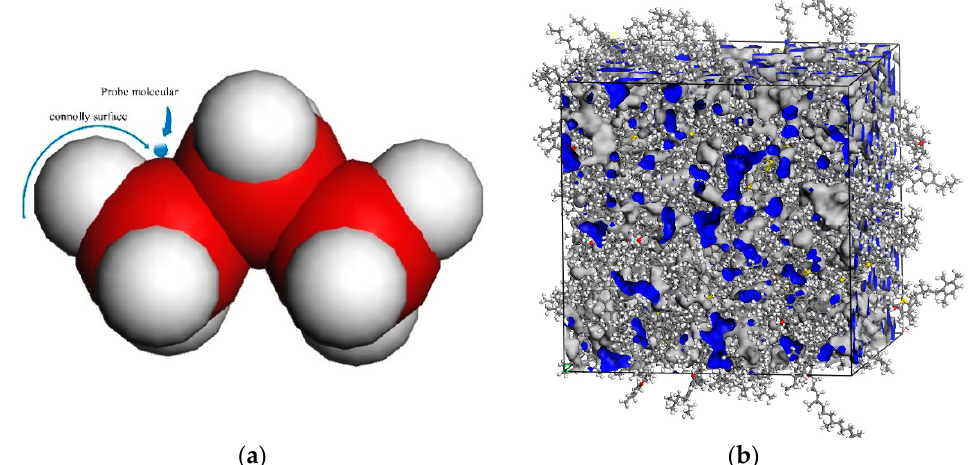
Figure 15. Morphology of the free volume at 331 K. ( a ) Schematic of the free volume calculation method; ( b ) base asphalt.